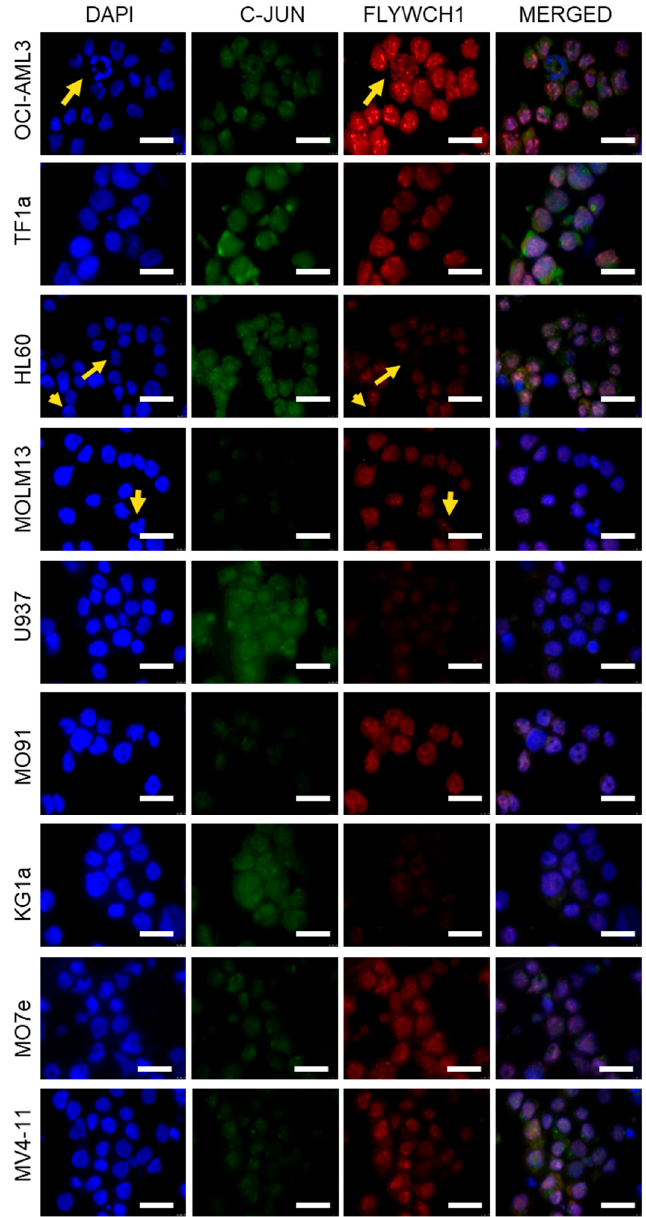
Figure 2. Diverse expression of FLYWCH1 and c-JUN proteins in AML cell lines. Immunofluorescence (IF) analysis of FLYWCH1 (red), c-JUN (green), with DAPI nuclear counterstain (blue). The loss of FLYWCH1 expression in dividing cells is demonstrated in magnified insets (yellow arrowheads). Scale bars, 50 μ m.